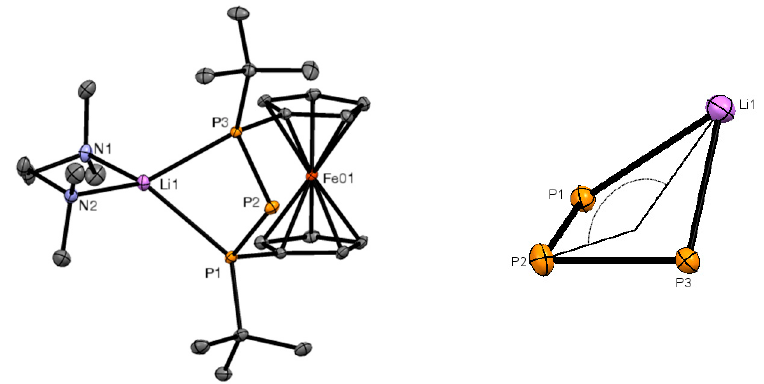
Figure 2. ORTEP plot of the molecular structure of 2 ( left ), and expansion of the folded P 3 Li ring ( right ). Ellipsoids were drawn at the 30% probability level. Hydrogen atoms were omitted for